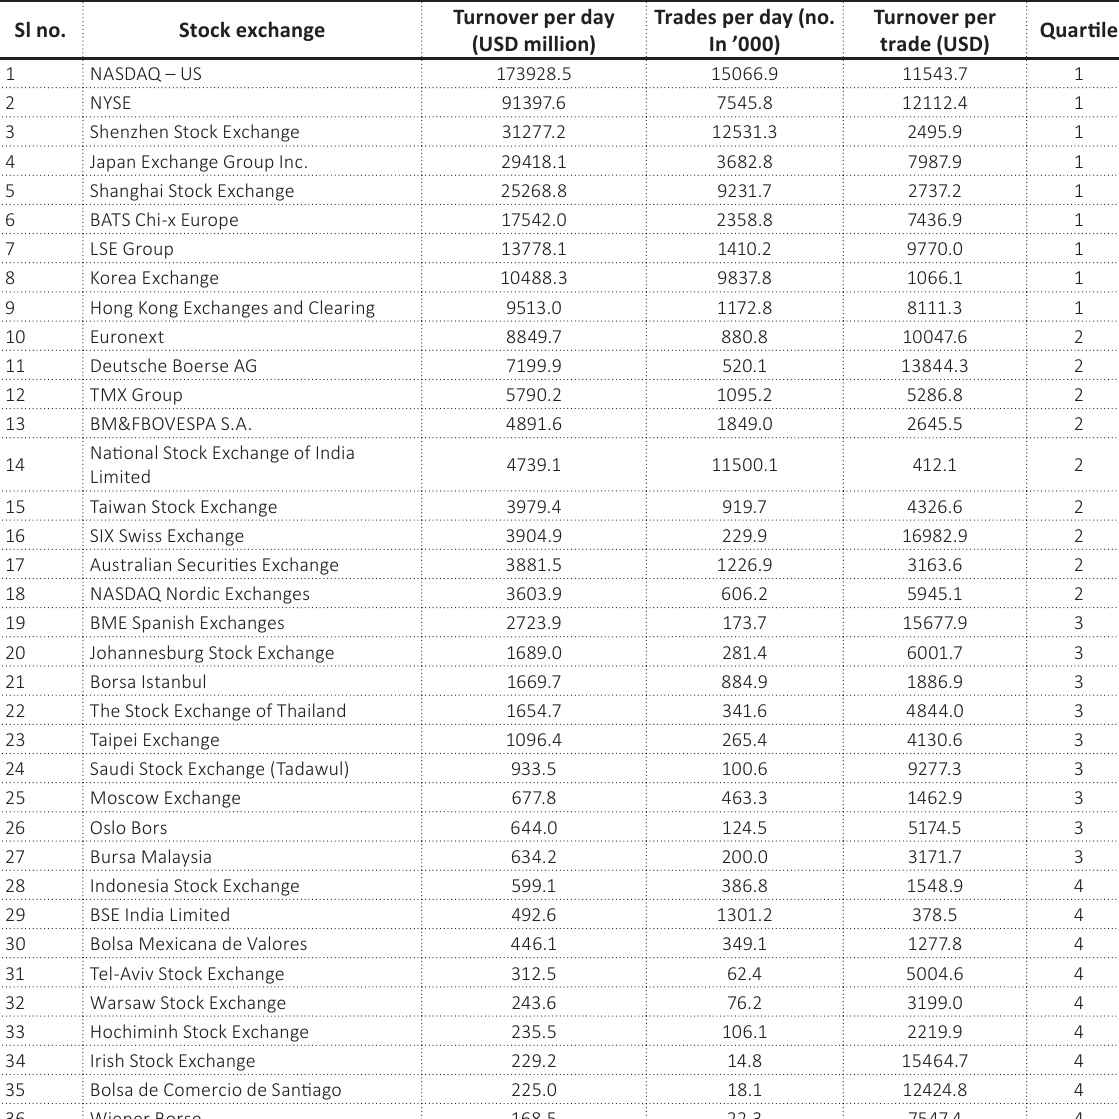
Table A1. Data sample for the year 2018